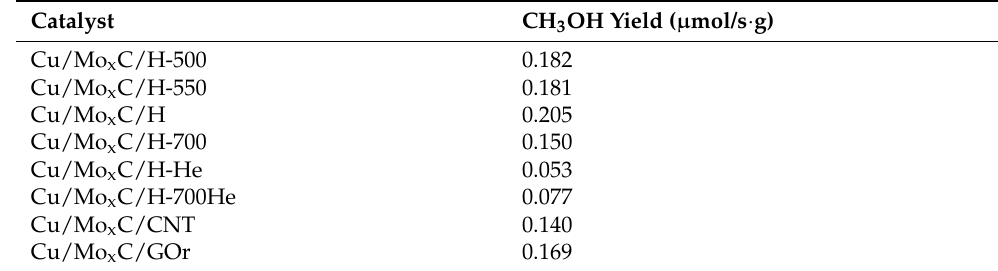
Table 2. Methanol yield obtained with the tested